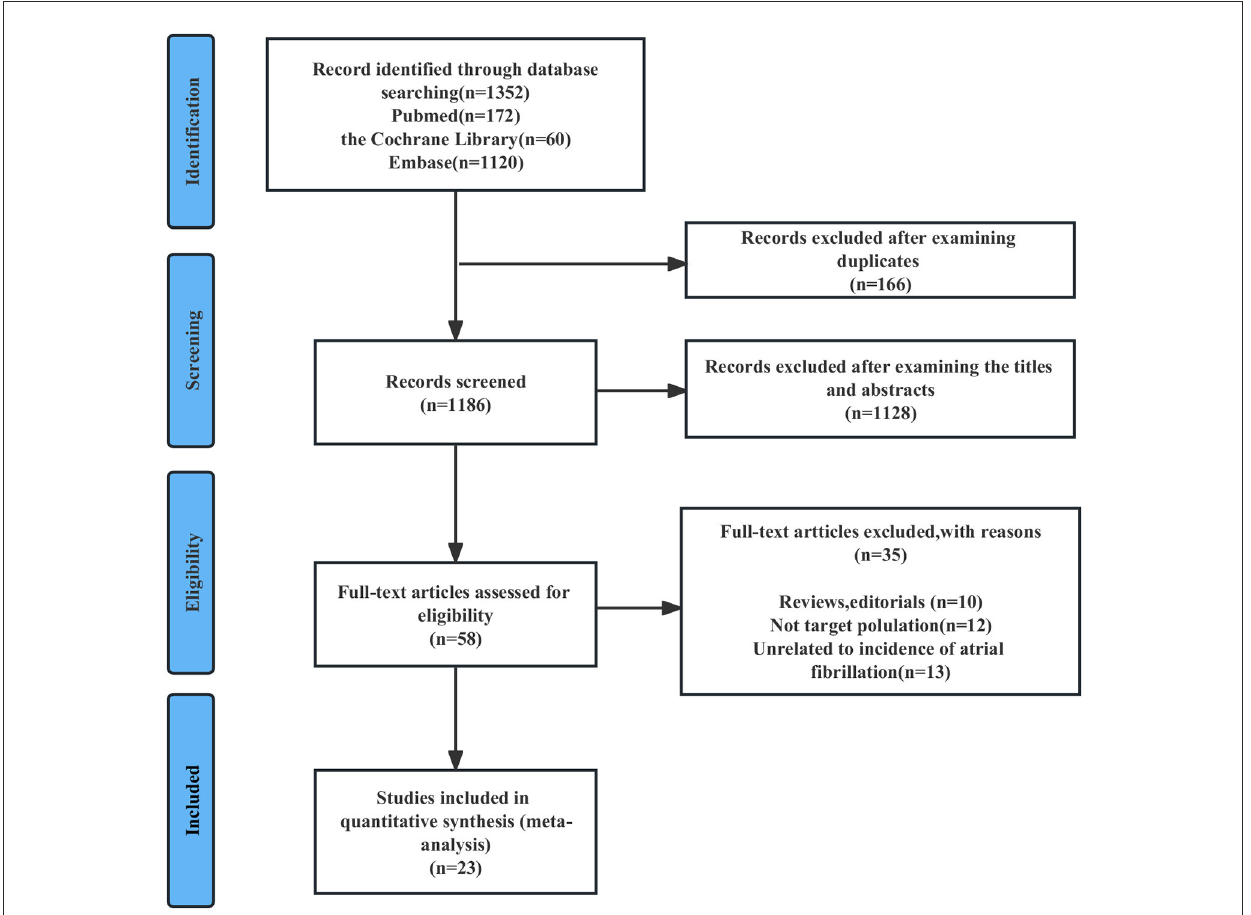
FIGURE1 Flowchart of study selection for the bidirectional association between AF and BC. AF, atrial fibrillation; BC, breast